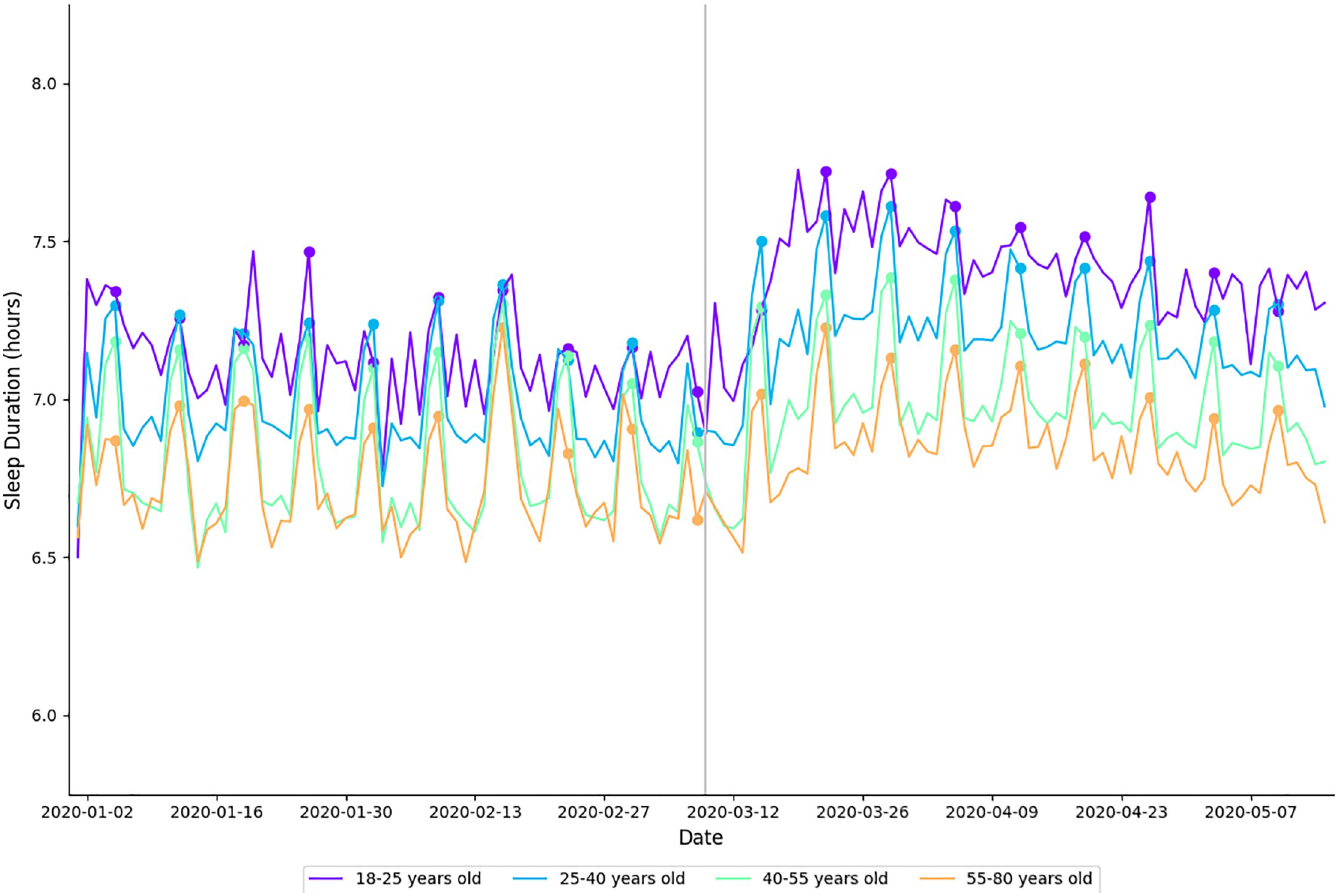
Fig 2. Daily average sleep duration in 2020 aggregated by age cohort. Each cohort is plotted in a different color, indicted in the legend. Filled circles indicate Sundays; a vertical gray line separates baseline and physical distancing. https://doi.org/10.1371/journal.pone.0256063.g002 Table 3. Daily percentage of users that engaged in exercise (i.e., exercise frequency) as a function of time period. Exercise frequency (%)